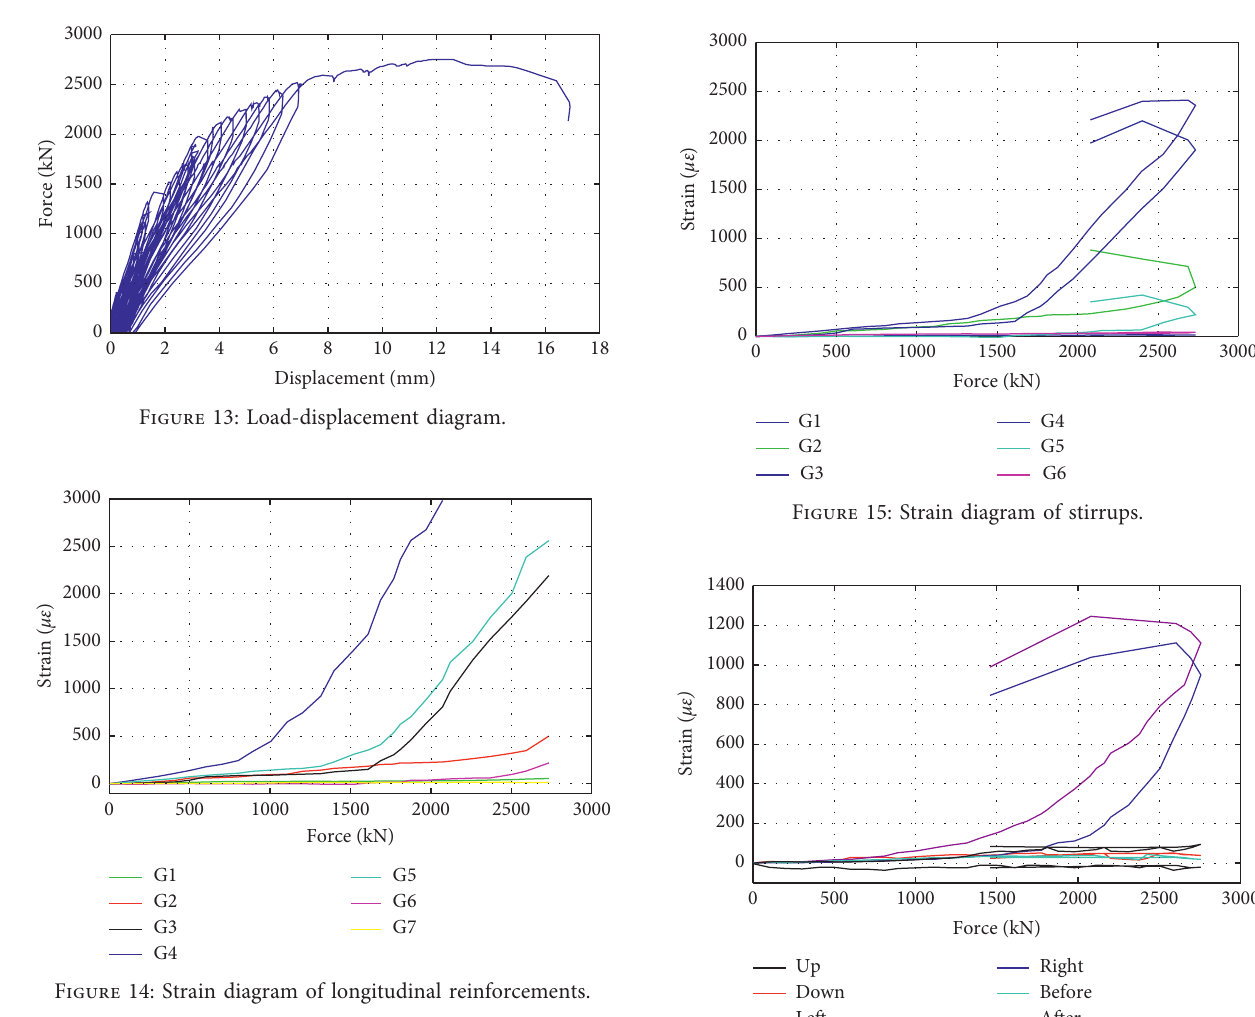
Figure 14: Strain diagram of longitudinal reinforcements.